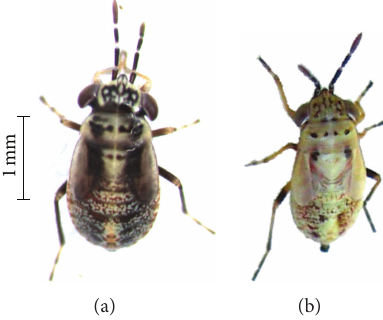
Figure 3: Color morphs of G. pallens nymphs. The dark (a) and the more common light (b) color morph are shown in the fourth instar. Size differences are not characteristic of the morphs but are rather due to individual